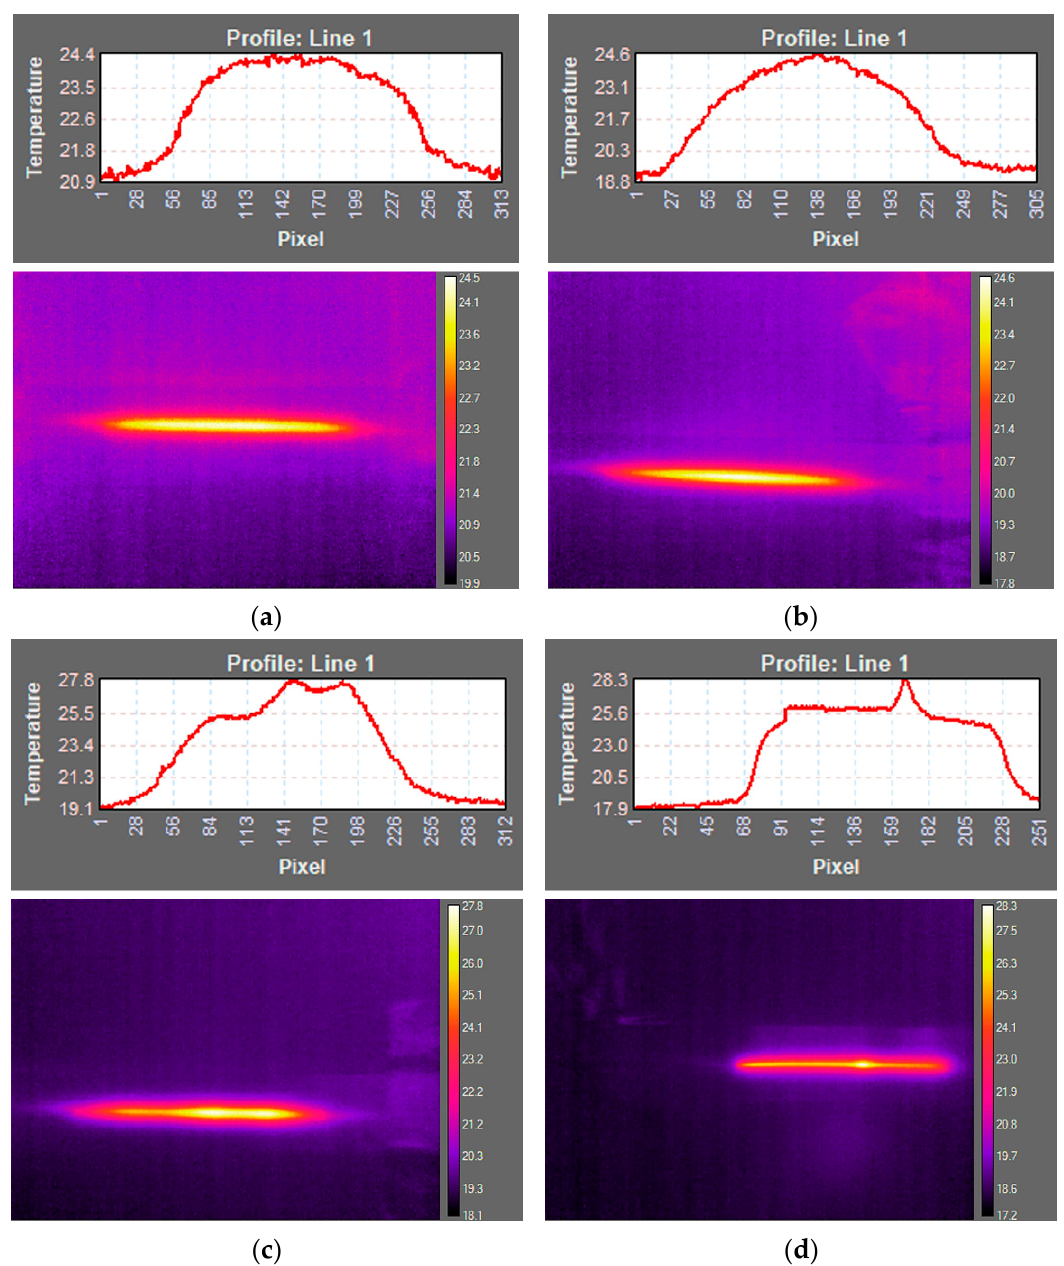
Figure 13. Thermographic inspection: ( a ) 70 A-8 before loading, ( b ) 70 A-8 after 200 cycles of 3PB, ( c ) 70 A-8 after impact, ( d )–T300-30 after impact.